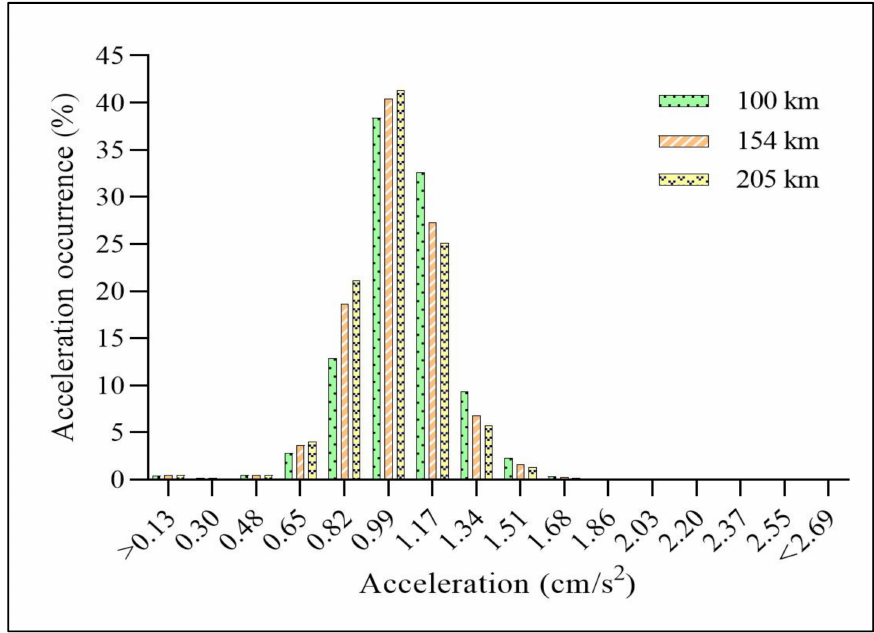
Figure 3. The occurrence percentage of the acceleration intervals (cm/s 2 ) for 100, 154, and 205 km distances in the vehicle during